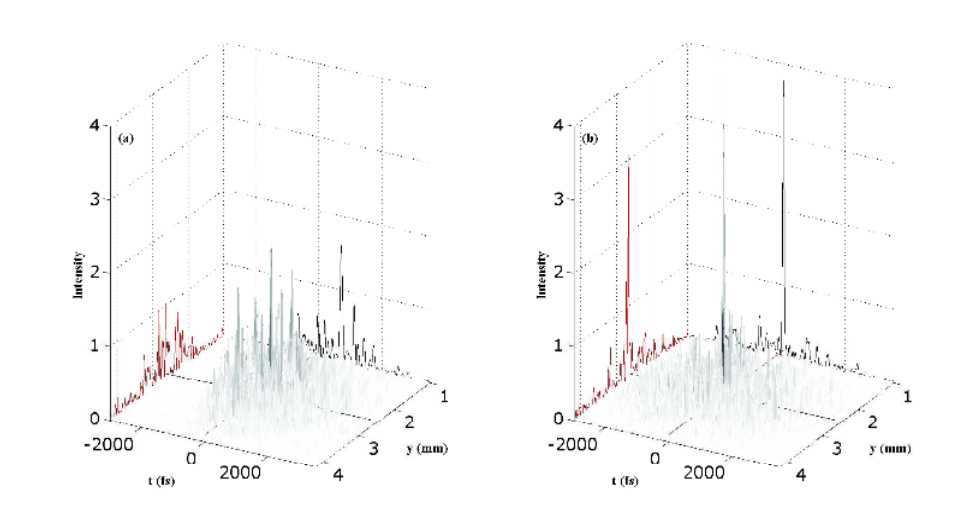
Fig. 3. Reconstructed spatio-temporal intensities (a) before and (b) after compensation of the phase at y = 2.66 mm. An intense peak emerges from the background with a contrast ratio of 15. One-dimensional lineouts at the location of this peak are projected onto the